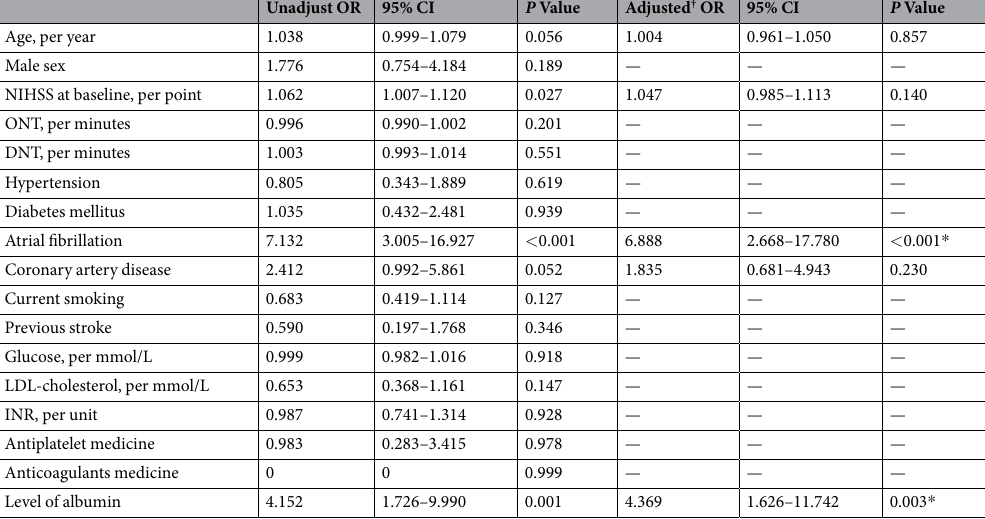
Table 3. Binary Regression Analyses Regarding the Occurrence of HT. * P < 0.05. NIHSS, National Institutes of Health Stroke Scale; ONT, onset to needle time; DNT, door to needle time; LDL, low-density lipoprotein; INR, international normalized ratio; CI indicates confidence interval; OR, odds ratio; HT, hemorrhagic transformation; OCSP, Oxfordshire Community Stroke Project. † Adjusted for all variables with P <